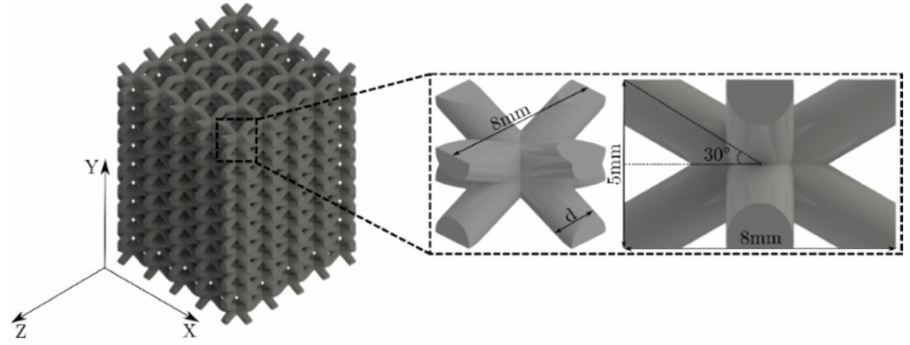
Figure 2. CAD model of the lattice structure and unit cell dimensions.